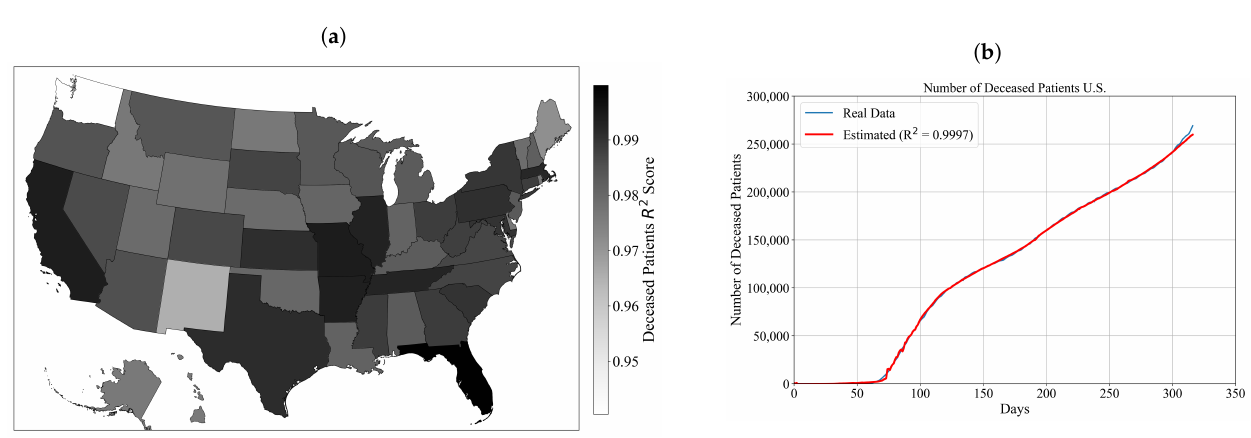
Figure 3. The obtained results for deceased patients: ( a ) the accuracy of obtained symbolic expressions used for estimation of number of deceased patients for each state achieved on the testing dataset in terms of R 2 score; and ( b ) the comparison of estimated and actual numbers of deceased patients through